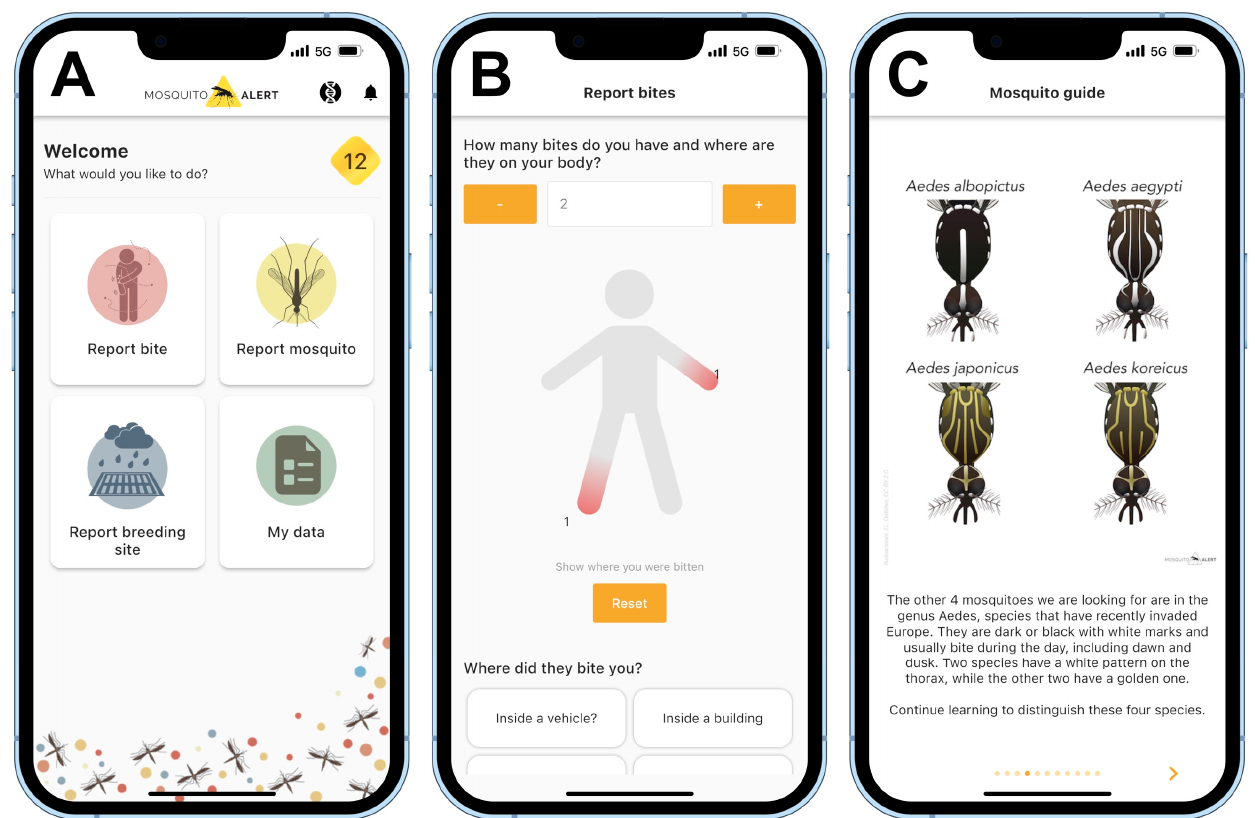
Figure 1. Mosquito Alert user interface. Screenshots illustrating the mobile app’s dashboard ( A ), bite reporting module ( B ), and species identification guide ( C ).